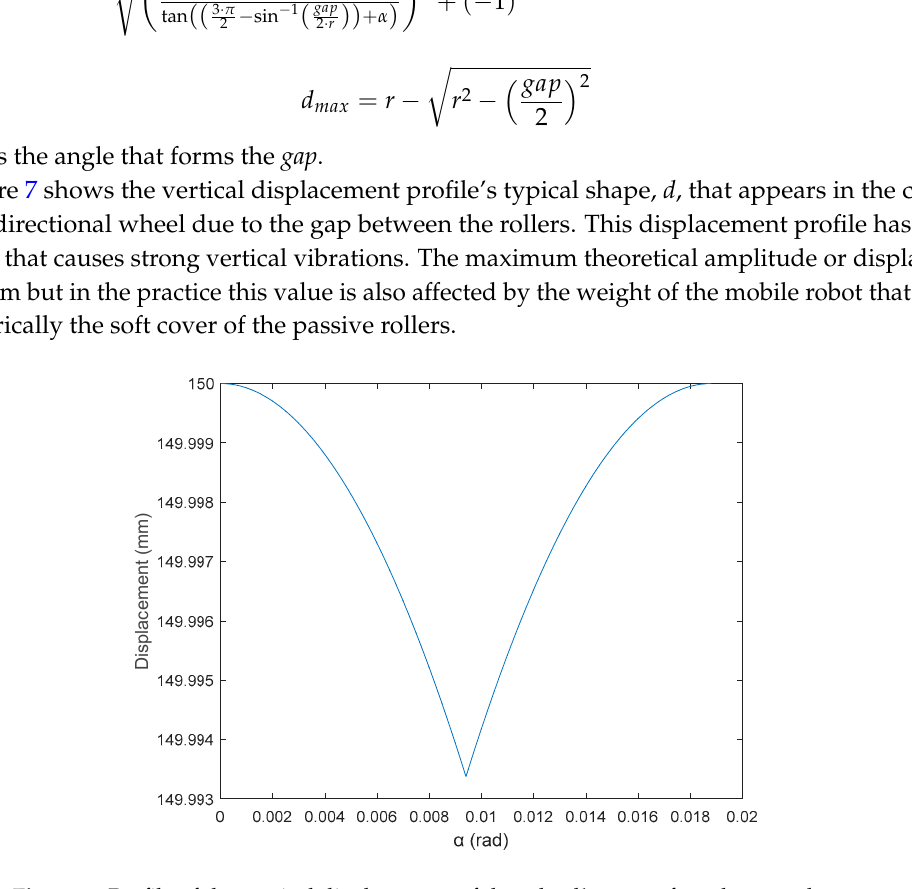
Figure 7. Profile of the vertical displacement of the wheel’s center found across the gap.